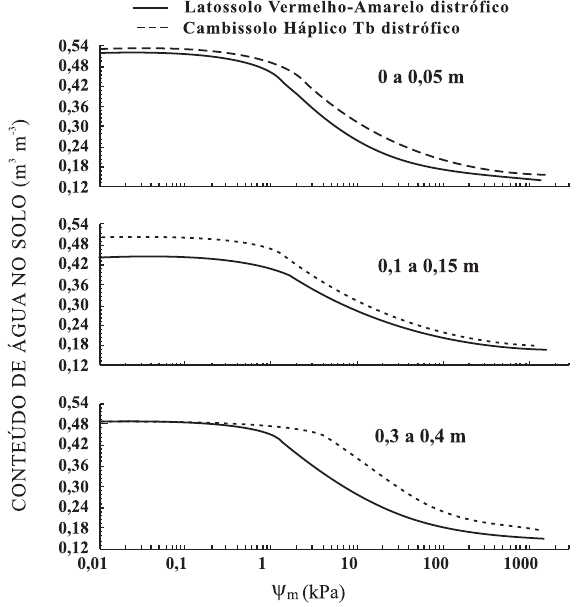
Figura 1. Curva característica de água [conteúdo de água no solo (U) em função do potencial matricial ( ψψ ψψ ψ )] no Cambissolo Háplico Tb m distrófico (CXvbd) e no Latossolo Vermelho- Amarelo distrófico (LVAd) nas profundidades de 0 a 0,05, 0,1 a 0,15 e 0,3 a 0,4 m, cultivados com cana-de-açúcar, no município de